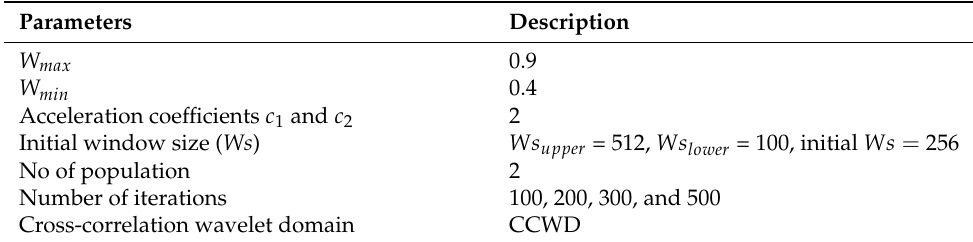
Table 1. Parameters of the IPSO-WT based techniques.